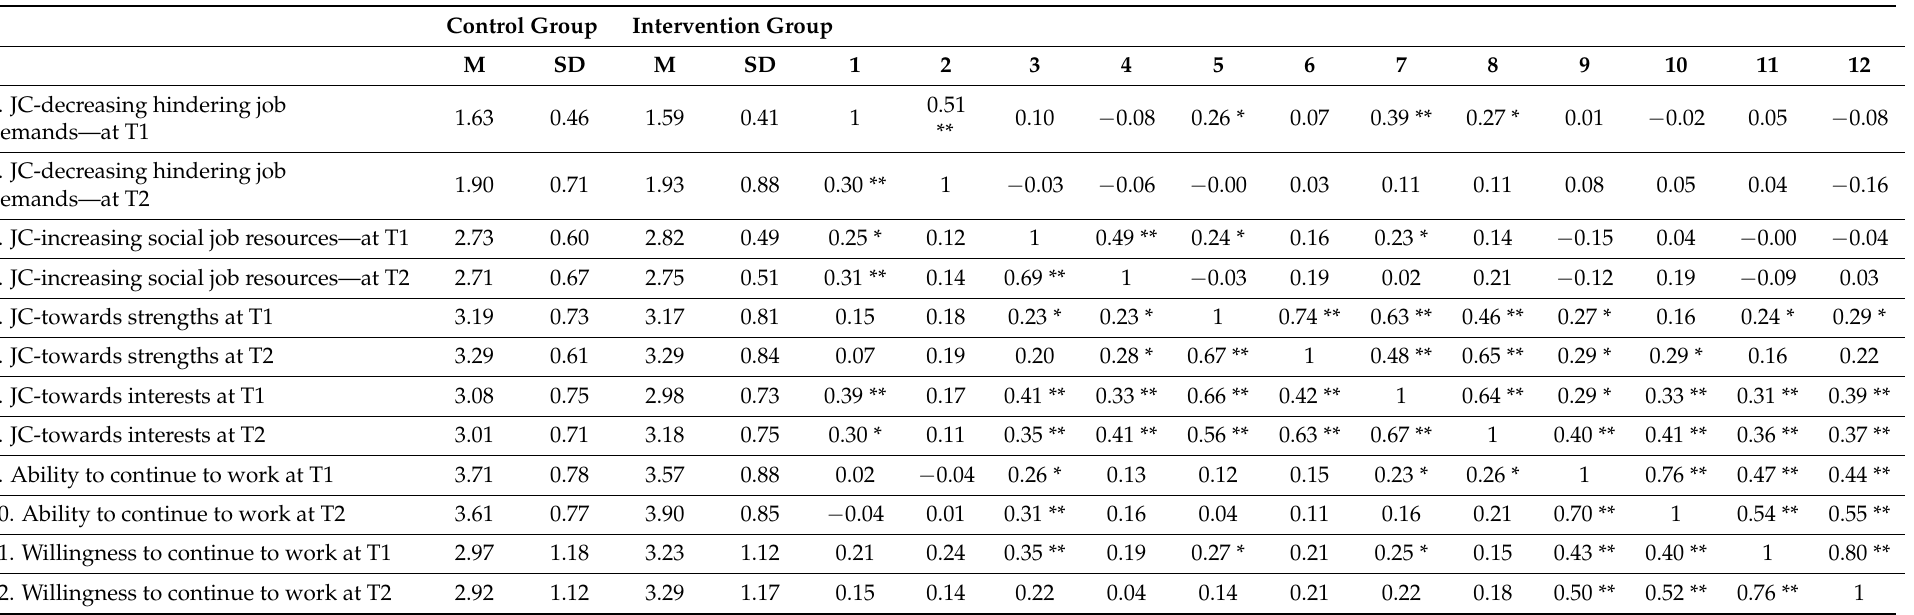
Table 1. Means, standard deviations and Pearson correlations of the main study variables. Control